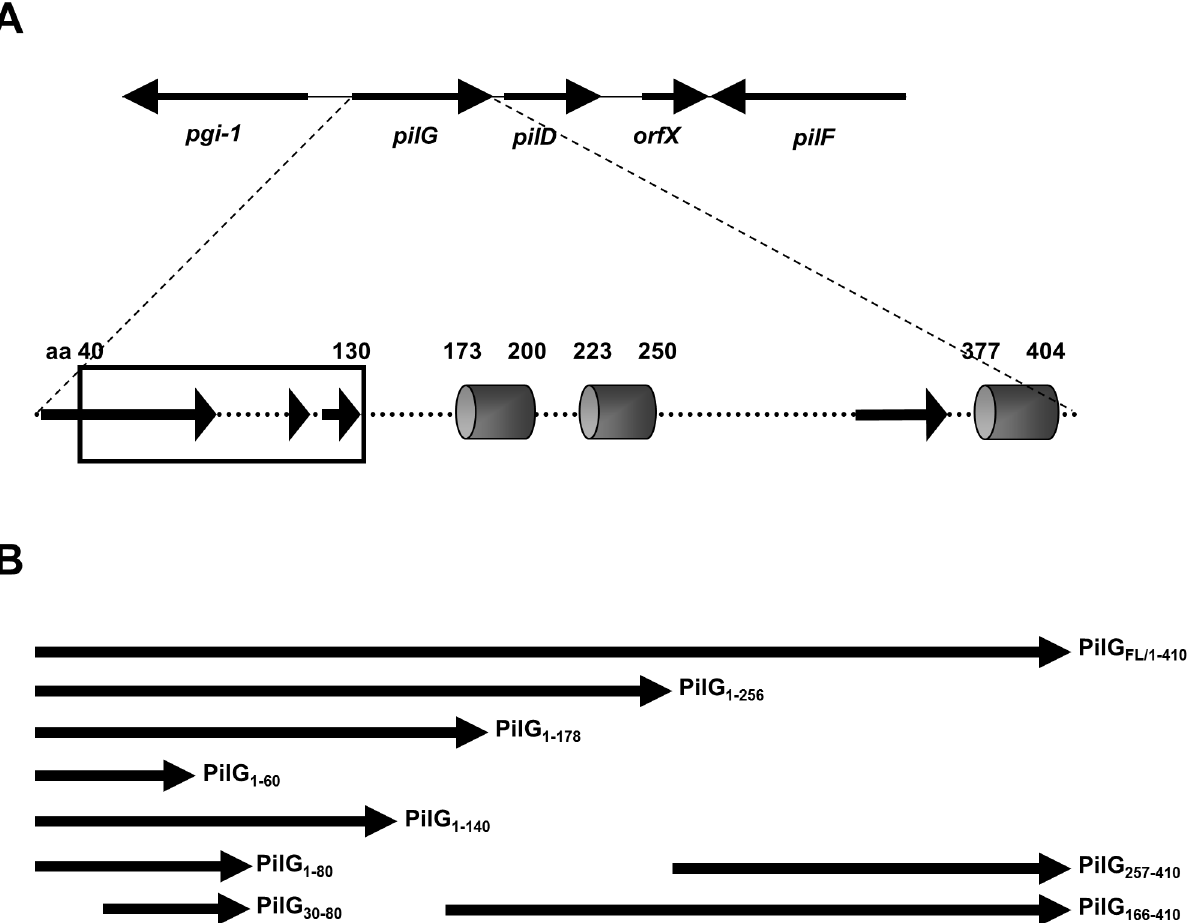
Fig 1. Schematic diagram of pilG gene organization. (A) Arrangement of pilG and flanking genes in N . meningitidis MC58 genomic DNA and structural predicted features of the PilG polypeptide. Transmembrane helices are indicated by gray cylinders and disordered regions by black arrows. A predicted DNA binding motif at the N-terminus of PilG is indicated by a black rectangle. (B) Schematic diagram of PilG expression constructs used in this study. All constructs contain a C-terminal 6× His-tag and the name of each construct is indicated to the right.